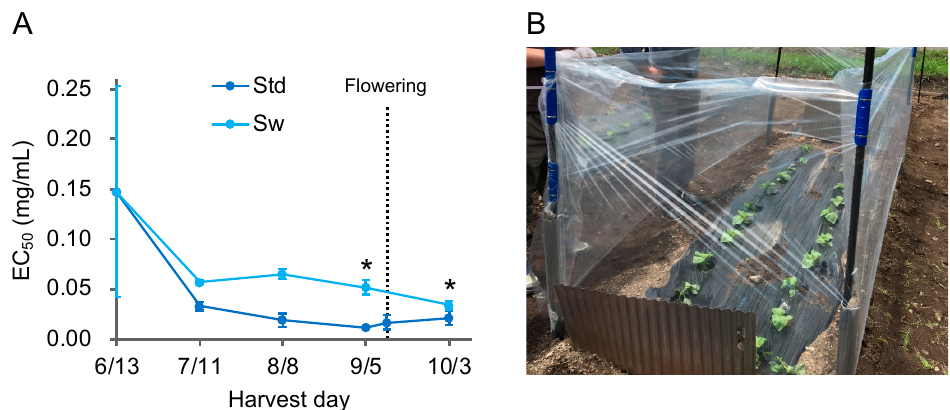
Figure 5. A β aggregation inhibitory activity showed the highest just before flowering, with wind enhancement. ( A ) A β aggregation inhibitory activity of leaves in regularly harvested Perilla frutescens var. crispa in 2019. P. frutescens var. crispa was planted on June 13, and whole plants were harvested every 4 weeks. Plants flowered on 12 September. The Std is the condition with no additional fertilizer under all conditions. Plants from Std were also harvested on September 12, during flowering. ( B ) Plants in the standard with windbreak (Sw) were cultivated in the same soil as Std and enclosed with a plastic sheet. Data represent the mean ± SD ( n = 3, separate plant). Comparison of the EC 50 values vs. Std harvested on September 5 (*: p < 0.05, Welch’s t -test).